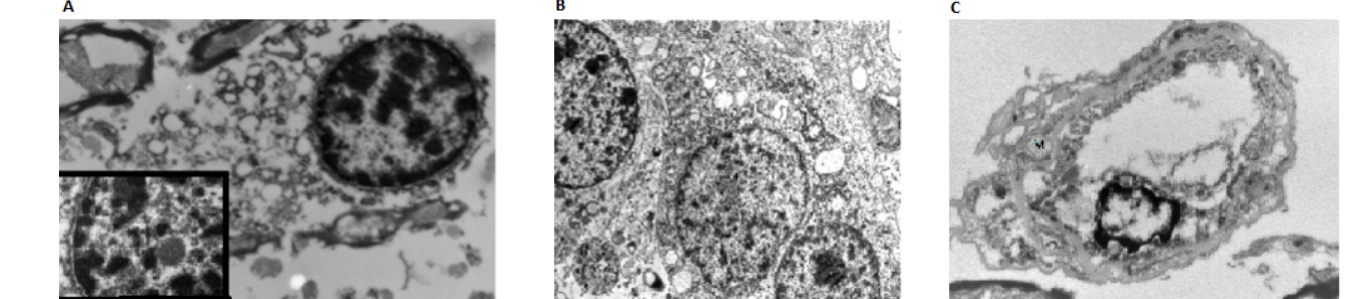
Figure 3. ( A ) TEM analysis in SARS-CoV-2 positive medulla oblongata showed cytoplasmatic vacuoles sized 180 to 211 nm. A nuclear body can be detectable (inset); ( B ) Neuronal cell with two synaptic structures (left) in the setting of a ganglioglioma for comparison; ( C ) a capillary shows severe artifactual alterations without viral-related structures: mitochondria (M) are swollen with fragmented cristae.